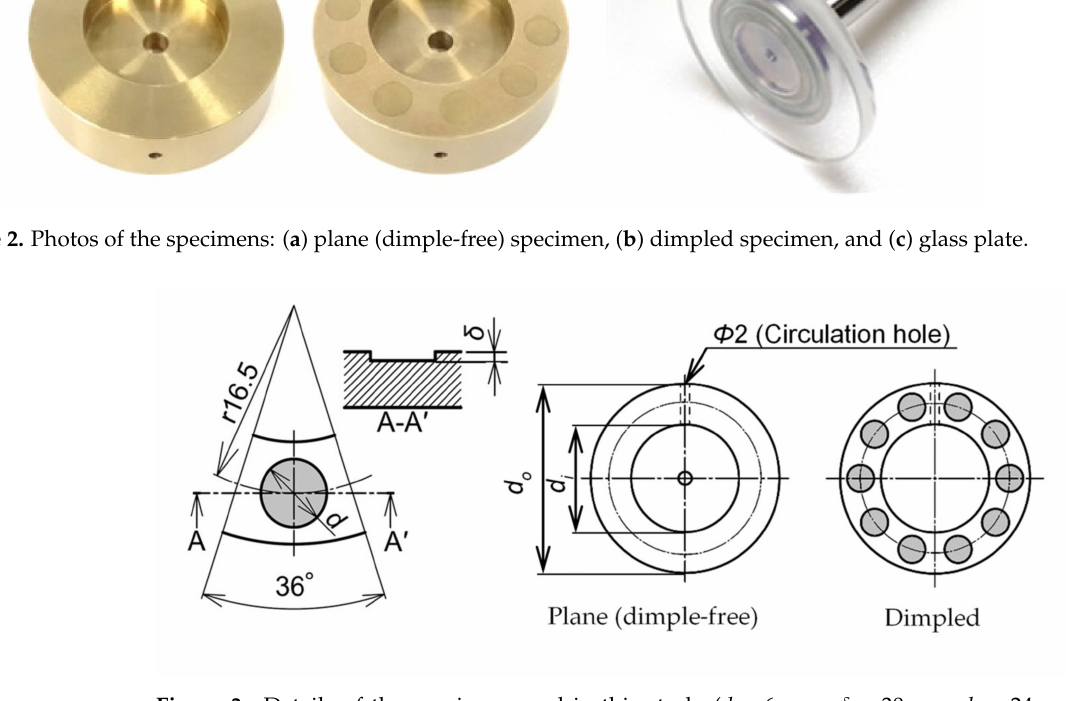
Figure 3. Details of the specimen used in this study ( d = 6 mm, δ = 30 µ m, d i = 24 mm, and d o = 42